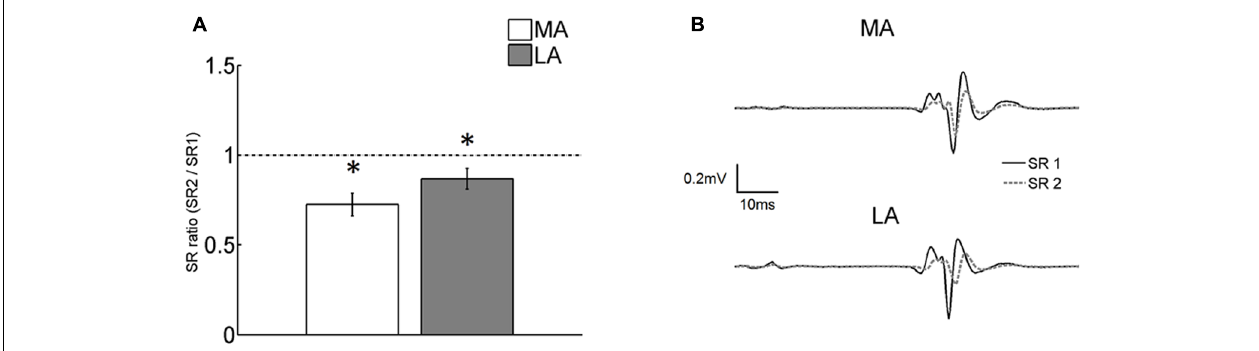
FIGURE 3 | (A) Comparison of the ratio of the first (SR1) and the second (SR2) SR evoked in the double pulse paradigm. The second response was significantly ( p < 0.05) depressed compared to the first one in both the LA and MA legs. The degree of HD was not